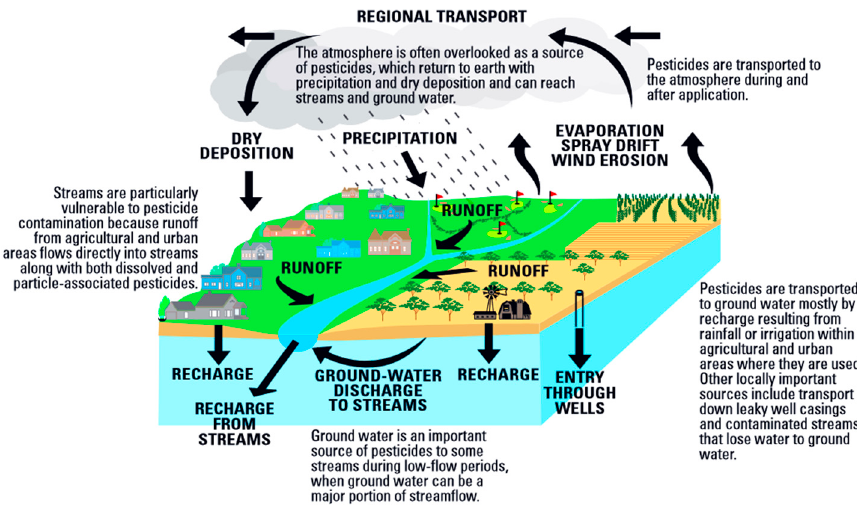
Figure 1. Pathways of pesticides transport to streams and groundwater [9,10].